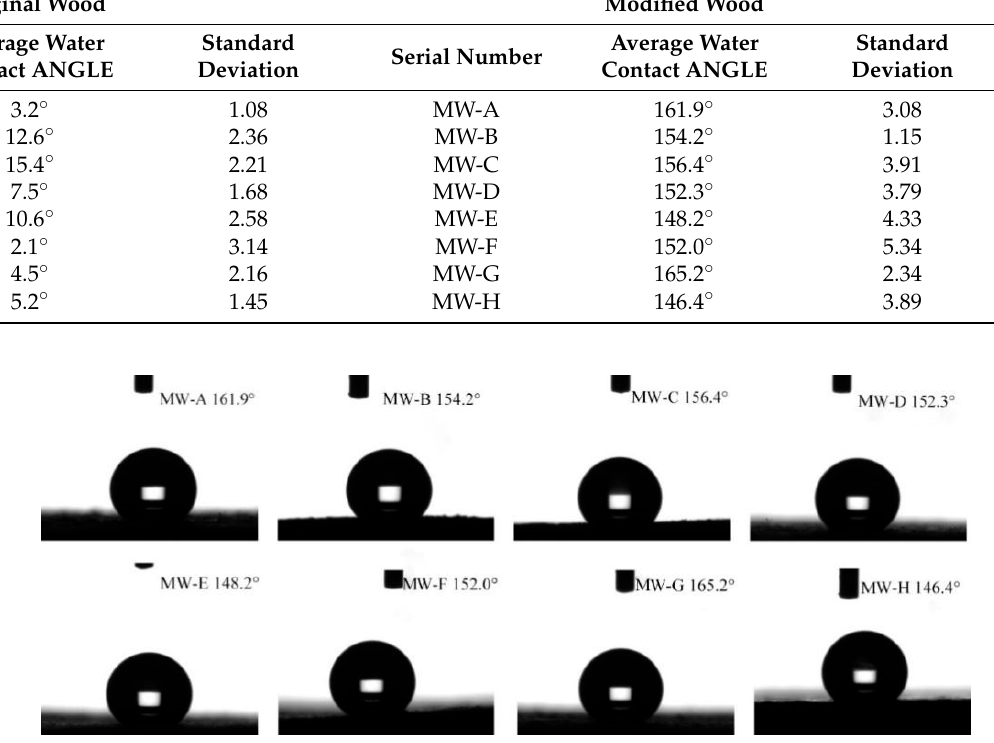
Figure 5. Water contact angle on the modi fi ed wood surface.